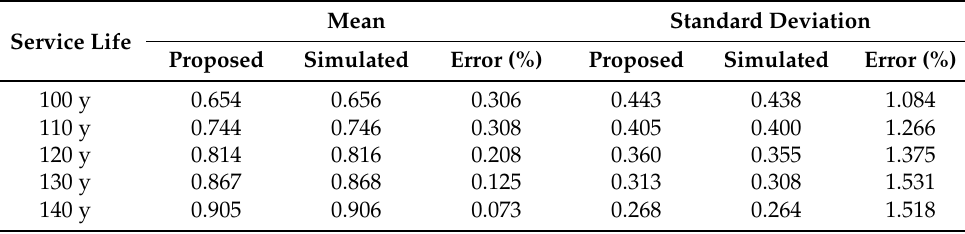
Table 5. Statistics of A sf ( t ) by the proposed and simulation-based methods ( µ ( x 0 ) = 50 mm). Service